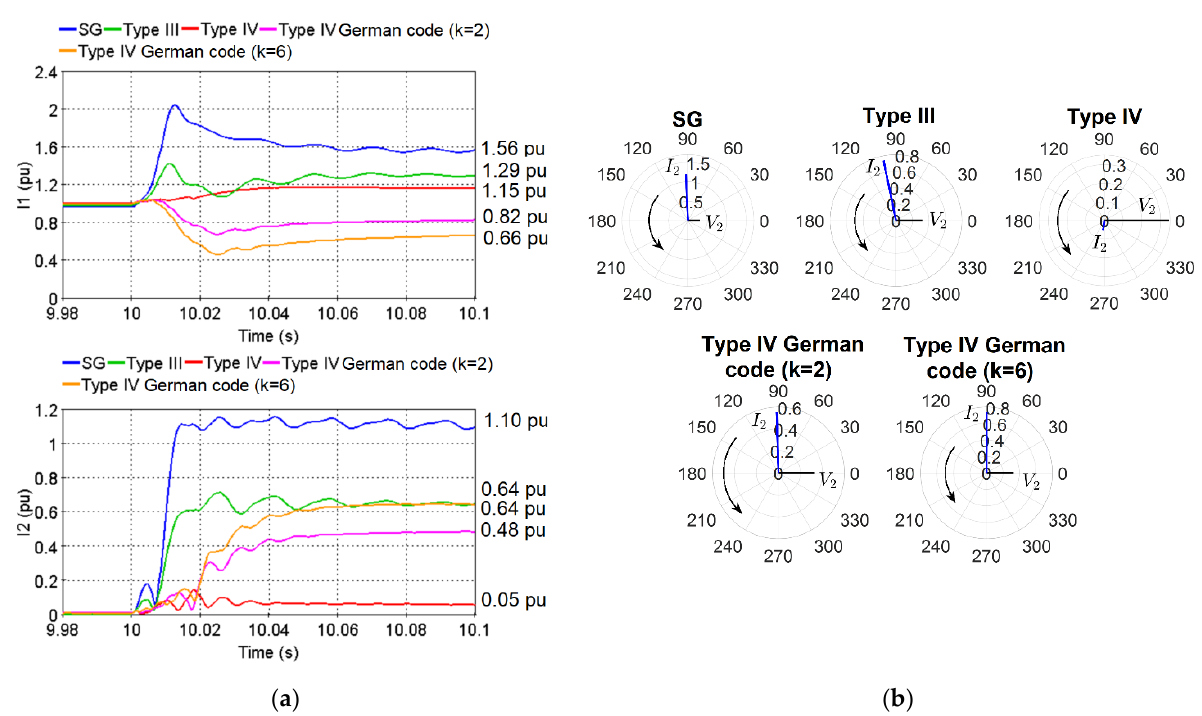
Figure 1. ( a ) Comparison of the amplitude of I1 and I2 of a SG, a Type III-, and a Type IV-based inverter-based resources (IBR) under the German grid code with various values of characteristic proportional gain k; ( b ) Phasor of V2 and I2 of a SG, a Type III-, and a Type IV-based IBR under the German grid code with various values of characteristic proportional gain k.